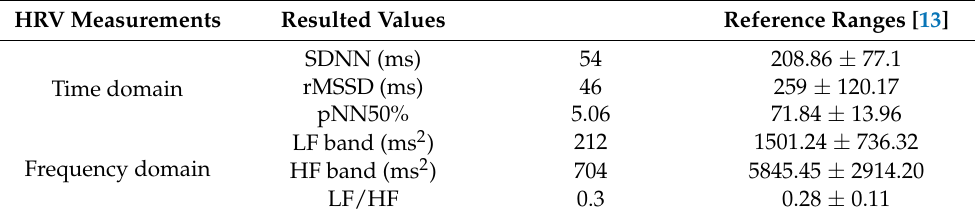
Table 1. Time and frequency domain heart rate variability values derived from 4.5 h Holter monitoring in a dog with kidney failure and reference values.